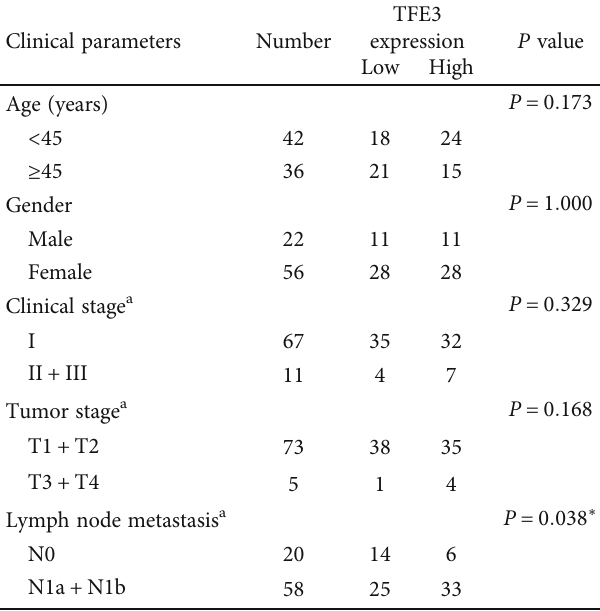
Table 1: Correlation between TFE3 expression andclinicopathological characteristics of thyroid cancer patients ( n = 78